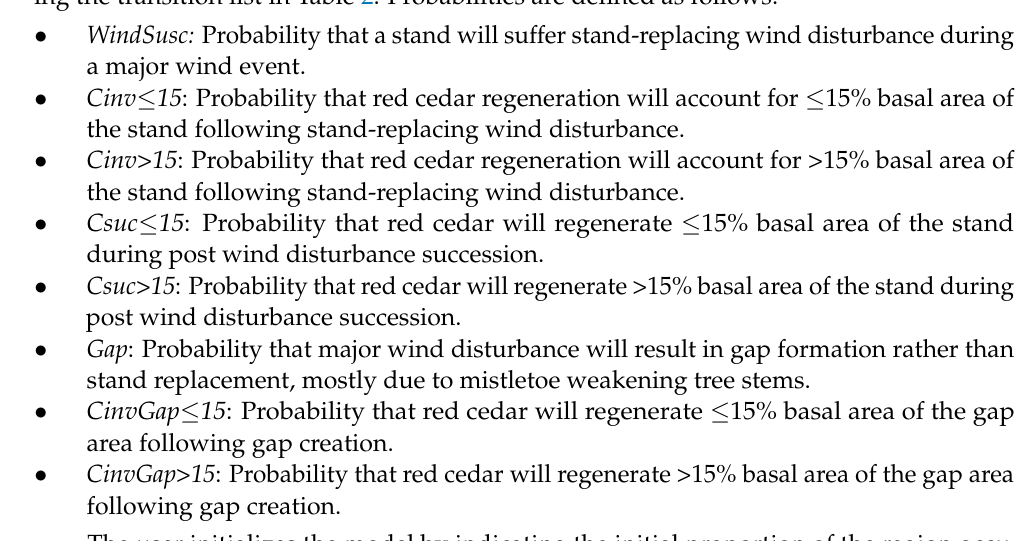
Figure 5. States and transitions of the multiple pathway hypothesis of succession in zonal sites on northeastern Vancouver Island. Adapted with permission from Ref [26]. ©2014 the Authors.